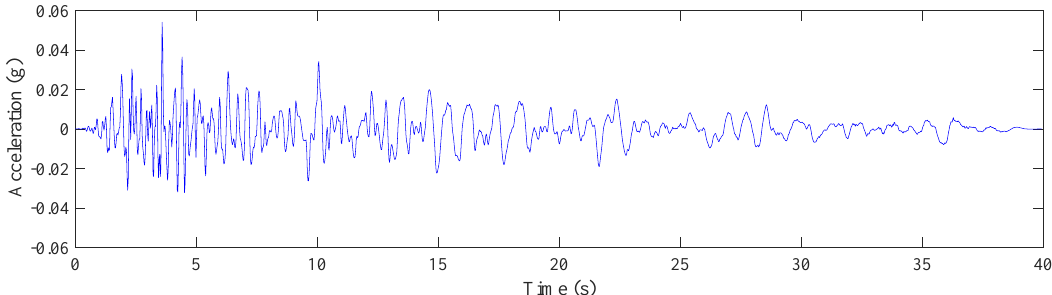
Figure 6. Input ground acceleration of the serviceability earthquake (Livermore earthquake,